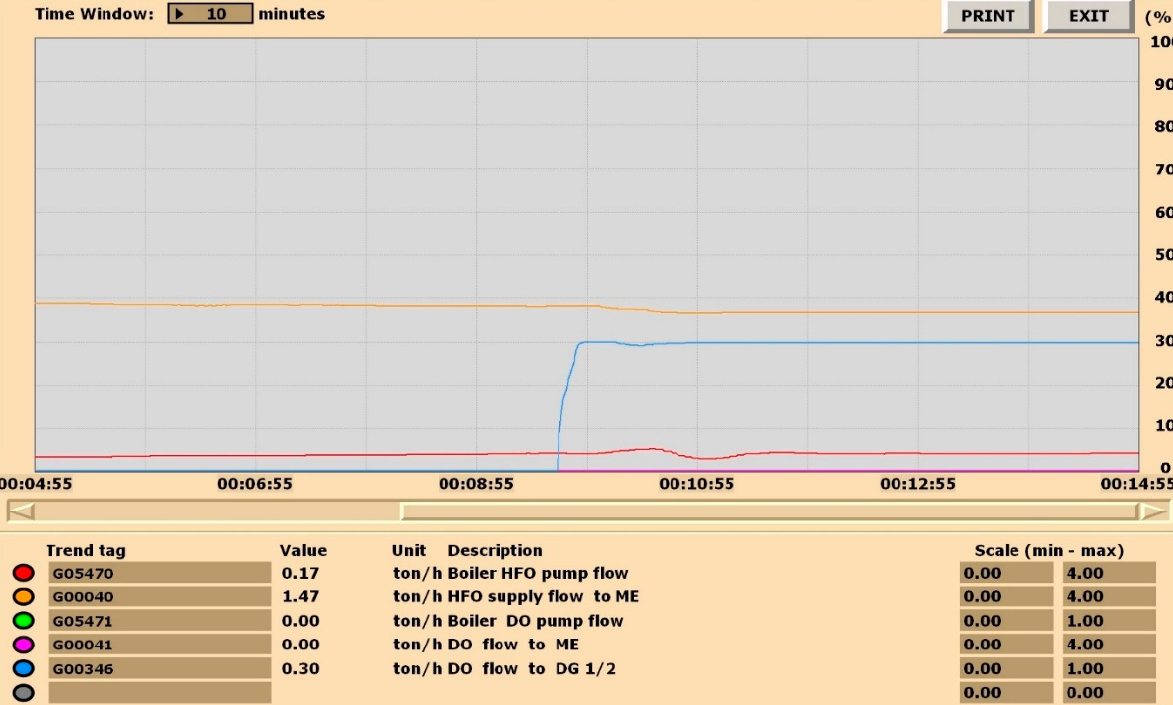
Figure 3. Fuel flows for mode 1.3.